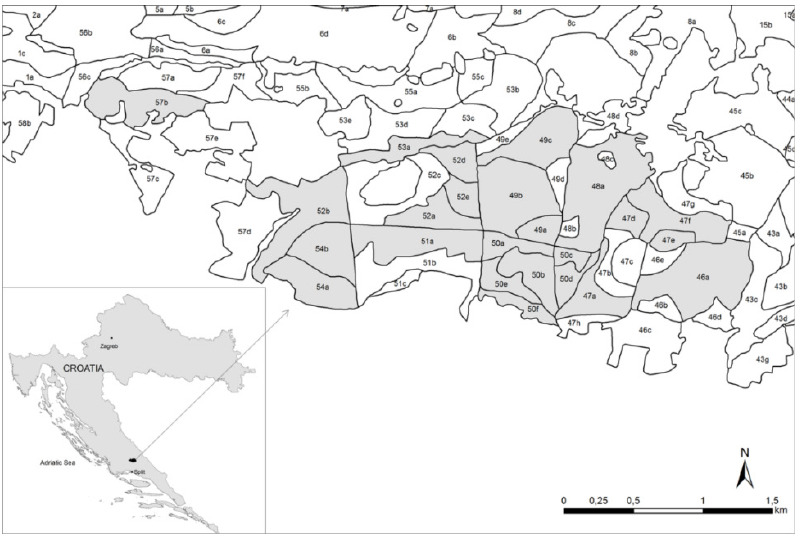
Figure 1. The location of the research area. Gray shaded subcompartments were selected for data